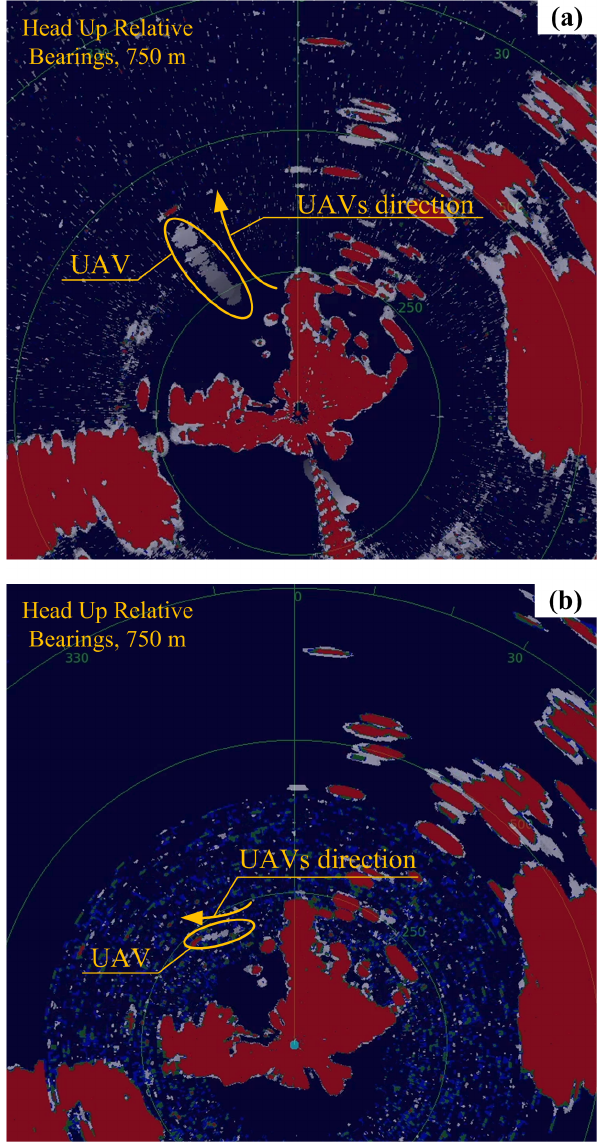
Figure 9. Detection of rotary-wing UAV by ( a ) Simrad 4G and ( b ) Halo20+